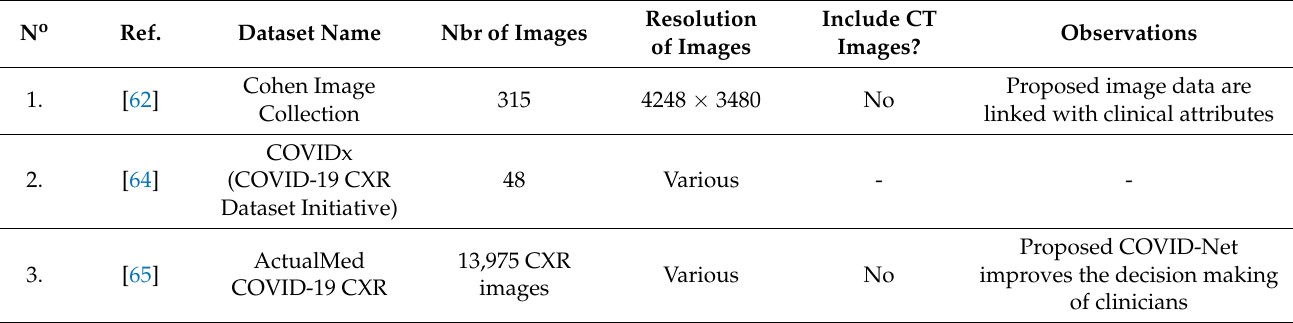
Table 2. Different COVID-19 CXR datasets used in the investigated works. N o